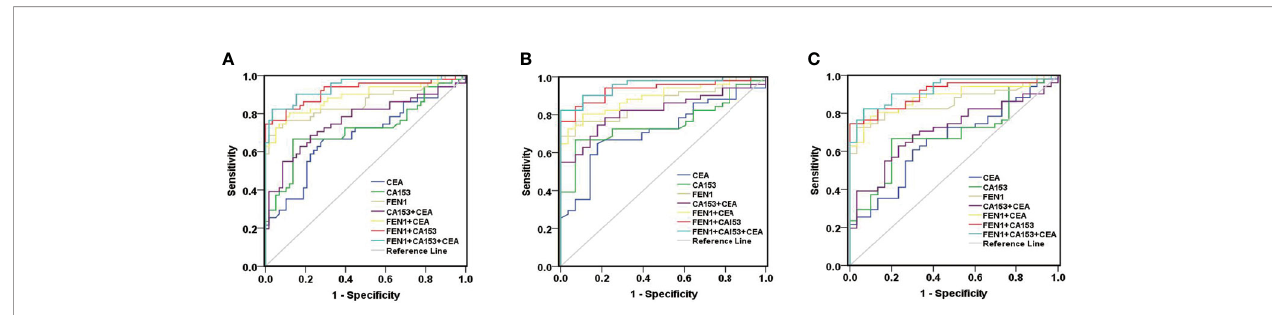
FIGURE 4 | ROC curves constructed to evaluate the diagnostic accuracy of FEN1 for BC. (A) For distinguishing BC patients from non-BC subjects. (B) For distinguishing BC patients from patients with benign breast diseases. (C) For distinguishing BC patients from healthy